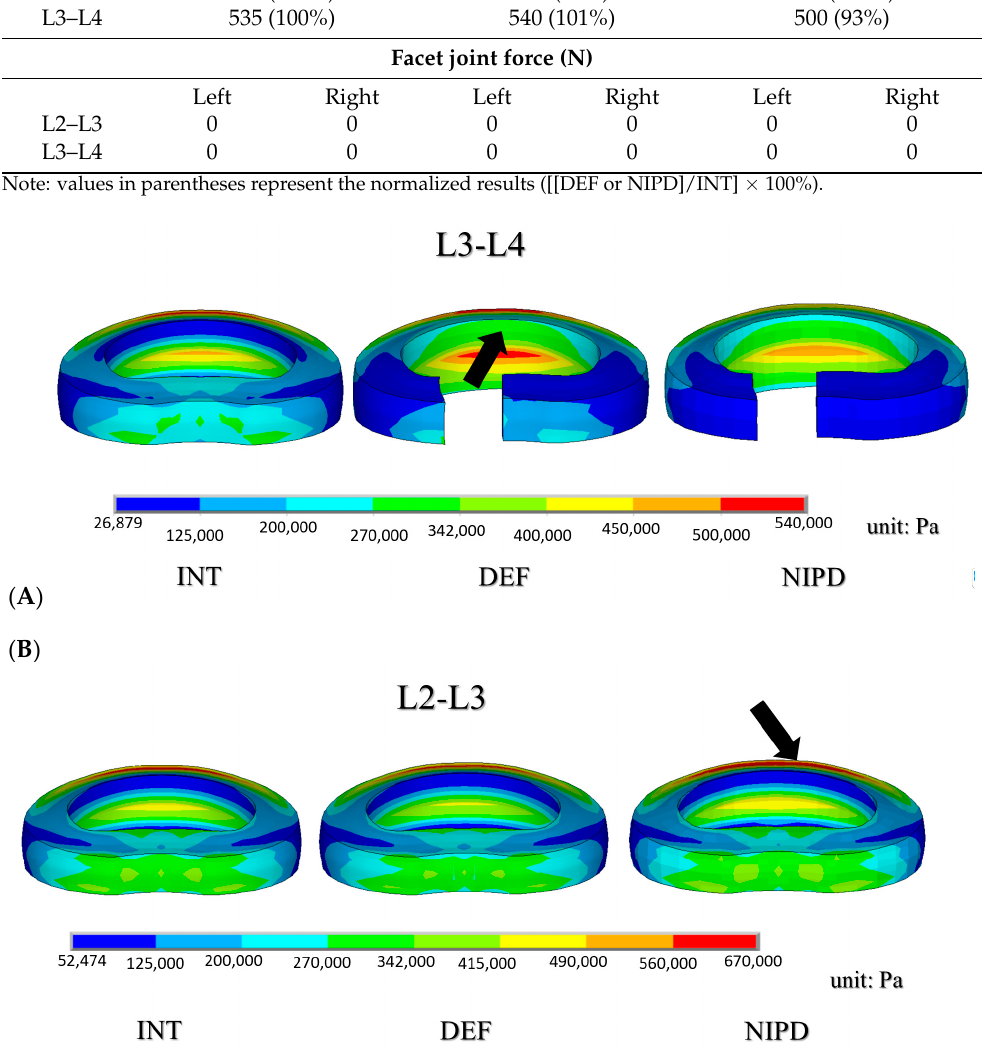
Table 3. Comparison of the biomechanical characteristics among the three FE models during exten- sion.